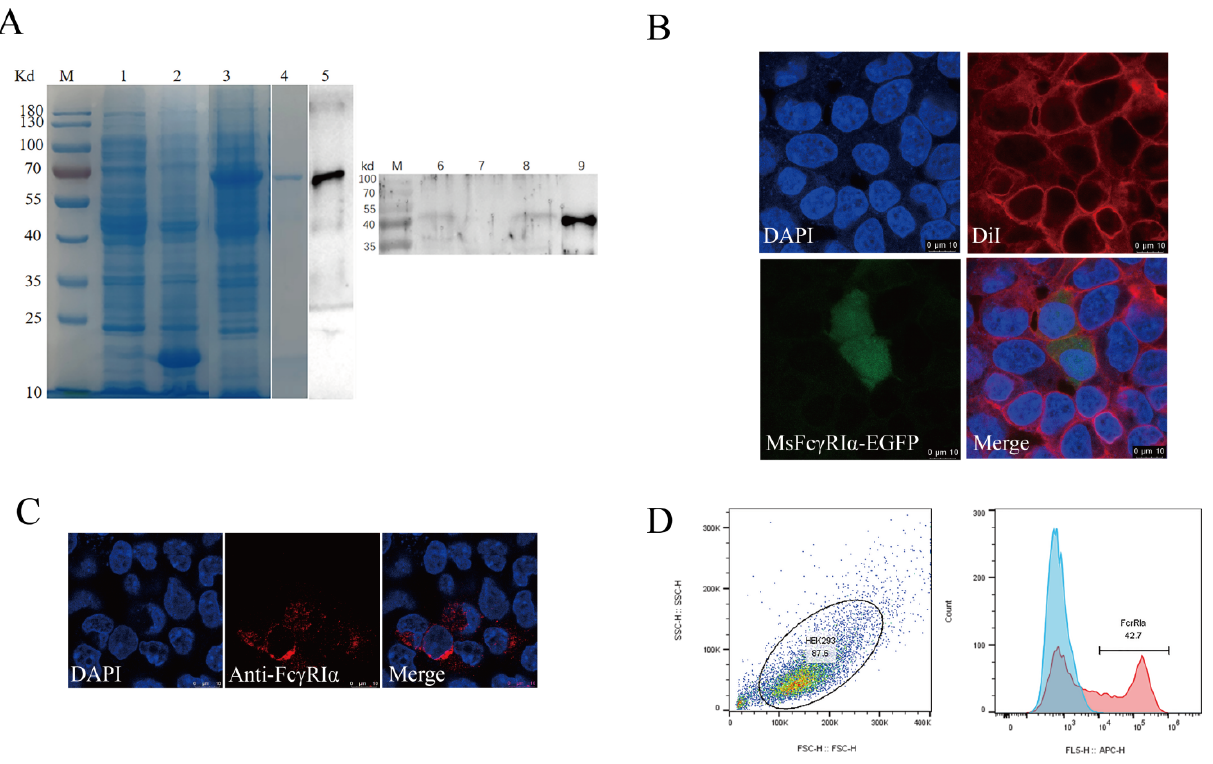
Figure 4. Antibody specificity and subcellular localization of MsFc γ RI α . ( A ) SDS-PAGE and Western blotting analysis of MsFc γ RI α . Lane M, molecular mass marker; lane 1, transformed E. coli without IPTG induction; lane 2, PET32a vector induced with IPTG; lane 3, MsFc γ RI α -PET32a protein induced with IPTG; lane 4, SDS-PAGE of purified MsFc γ RI α -PET32a protein (64.6 kDa); lane 5, Western blotting of MsFc γ RI α -PET32a protein (64.6 kDa); line 6, Native MsFc γ RI α in largemouth bass serum with N. seriolae immunization (47 kDa); line 7, Native MsFc γ RI α in largemouth bass serum without N. seriolae immunization; lane 8, Supernatants of HEK293 cells transfected with Fc γ RI α -pcDNA3.1(+) (47 kDa); line 9, Cell lysates of HEK293 cells transfected with MsFc γ RI α -pcDNA3.1(+) (47 kDa). ( B ) Subcellular localization of MsFc γ RI α on HEK293 cells; Green fluorescence representing MsFc γ RI α -EGFP is mainly located on cytoplasm and cell membrane. Scale bar = 10 µ m. ( C ) Detection of MsFc γ RI α -pcDNA3.1(+) on transfected HEK293 cells by anti-MsFc γ RI α PcAb. The red signal means that MsFc γ RI α is successfully expressed and specifically recognized by anti-MsFc γ RI α PcAb. Scale bar = 10 µ m. ( D ) Flow cytometric analysis of the percentage of HEK293 cells expressing MsFc γ RI α after 24 h